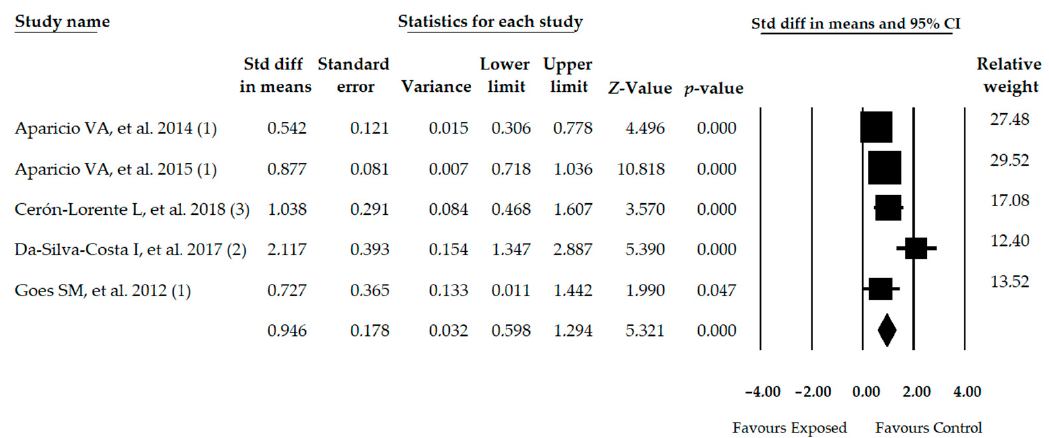
Figure 5. Forest plot of the meta-analysis of dynamic balance. Std diff, Standardized difference; CI, Confidence interval.